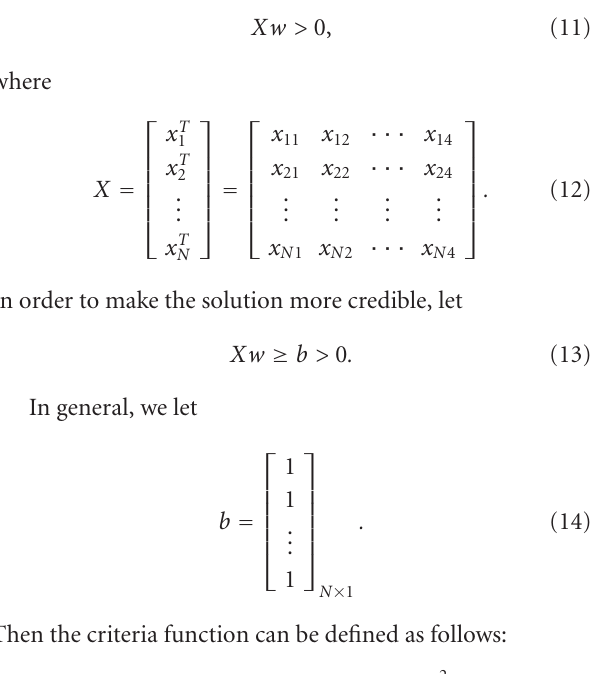
Table 3: Summary of block features Err for each